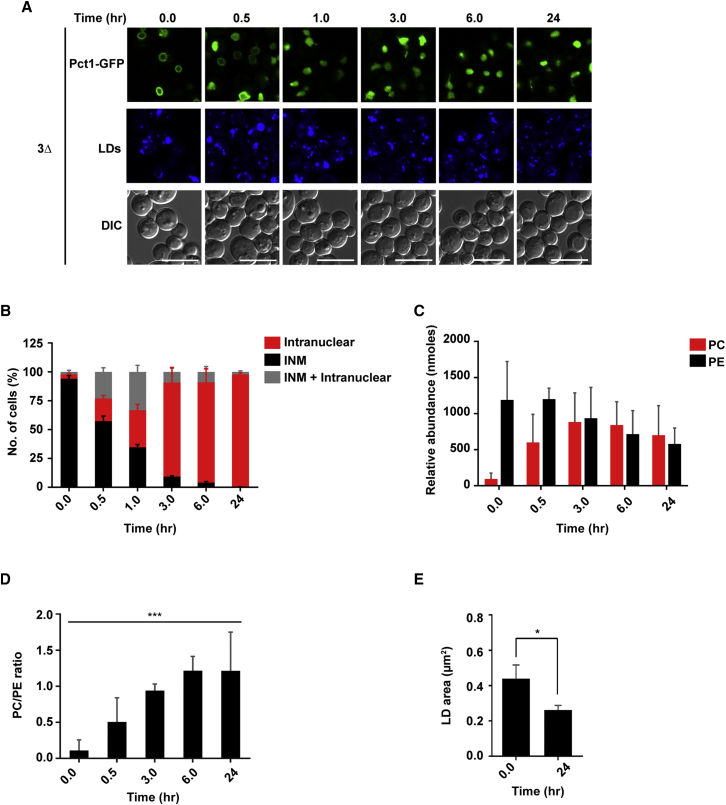
Changes in the PC/PE Ratio Correspond to Choline-Induced Pct1-GFP Translocation off the Nuclear Membrane3Δ yeast cells expressing Pct1-GFP were grown for 24 hr followed by addition of 1 mM choline. Cells were collected before (0.0 hr) and after choline supplementation at the indicated time points for imaging or lipidomics analysis.(A) Representative confocal microscopy images of Pct1-GFP localization. LDs were stained as described in the STAR Methods. DIC images are shown for context. Scale bars, 10 μm.(B) Quantification of the Pct1-GFP localization shown in (A). INM, Inner nuclear membrane. Data are means ± SD from three independent experiments; ∼300 cells were counted from random fields at each time point per experiment.(C) PC and PE levels at the indicated time points are shown in nmol (per 50 mg yeast) relative to internal standards. Data represent the means ± SD from three independent experiments.(D) PC/PE ratio at the indicated time points. Data are means ± SD. One-way ANOVA, ∗∗∗p < 0.001.(E) Measurement of LD area as described in the STAR Methods section from cells imaged in (A). Data are means ± SD from three independent experiments; ∼ 600 LDs were counted in each condition. Two-tailed Student's t test, ∗p < 0.05.See Figures S5 and S6.